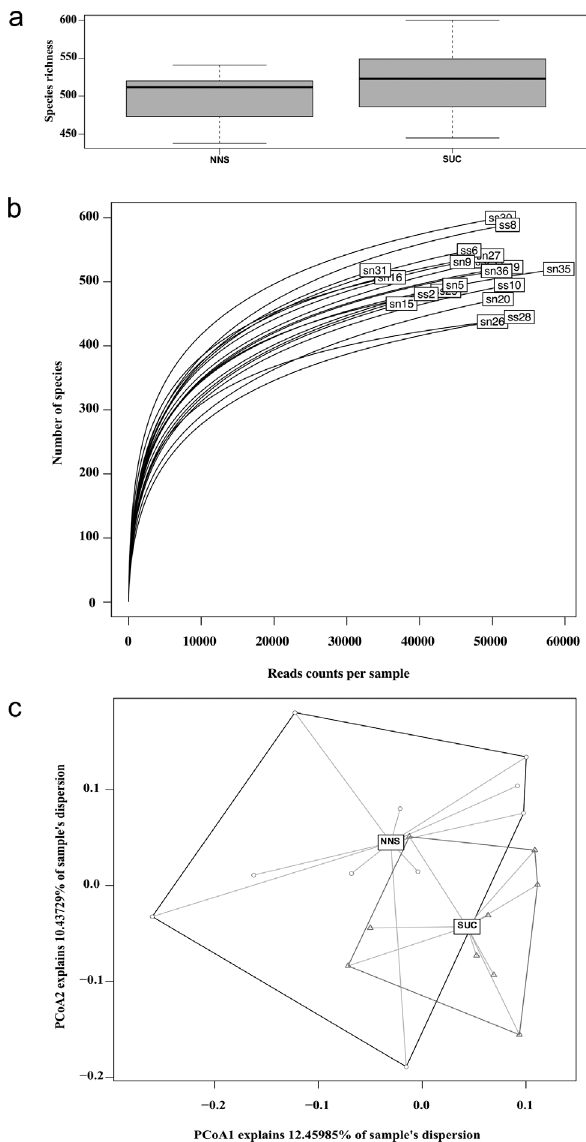
Figure 1 - Diversity analysis plots. (a) Species richness boxplot. The dark line inside the boxplots is the median, separating the upper quantile. Error bars represent the standard deviation. (b) Rarefaction plot per sample. sn, samples belonging to the NNS group; ss, samples belonging to the SUC group.Numbersindicatethenumberoftheratintheboxforinternalanno- tation. (c) Weighted beta diversity plot using principal coordinate analy- sis. Black circles represent the NNS samples; red triangles represent the SUC samples. Dark lines connect the most distant samples from the cen- troid of the NNS group, while red lines connect the most distant samples from the centroid of the SUC group. NNS, non-nutritive sweetener (n = 10); SUC, sucrose (n =